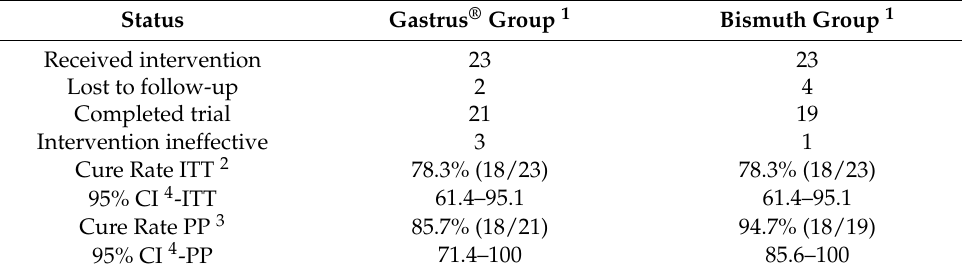
Table 2. Intervention status of 46 patients enrolled in the